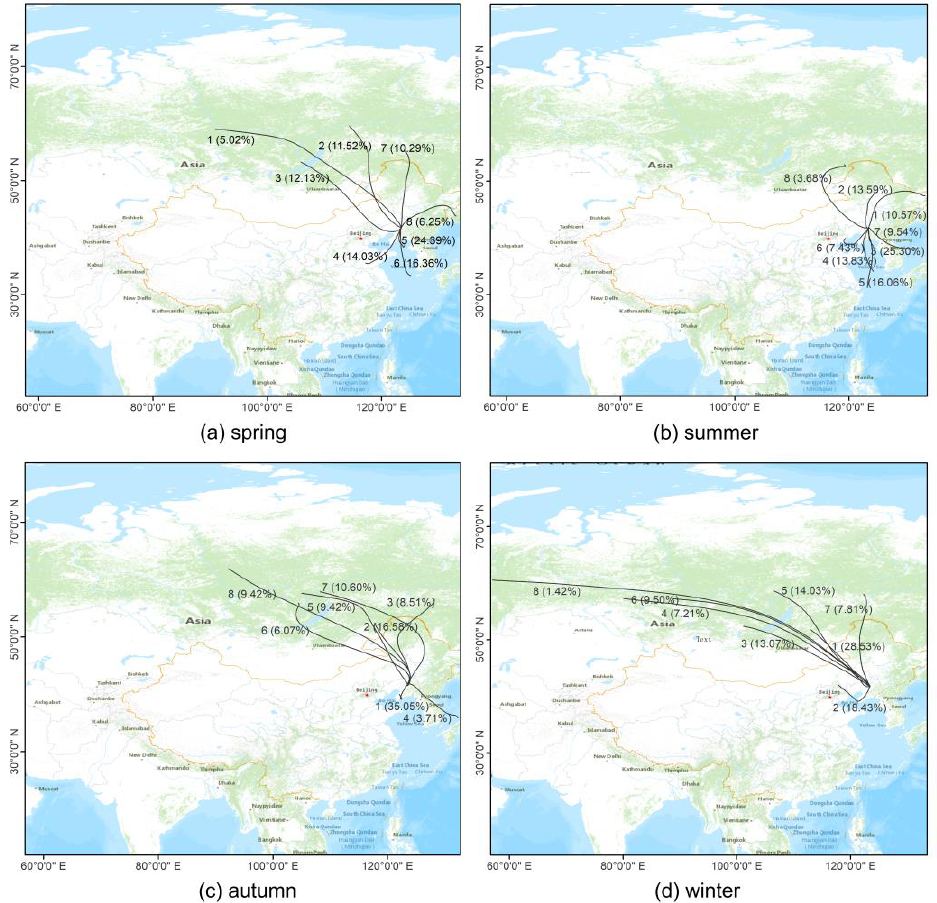
Figure 8. Cluster distribution of backward trajectories in different seasons in Shenyang in 2019: ( a ) spring, ( b ) summer, ( c ) autumn, ( d ) winter.